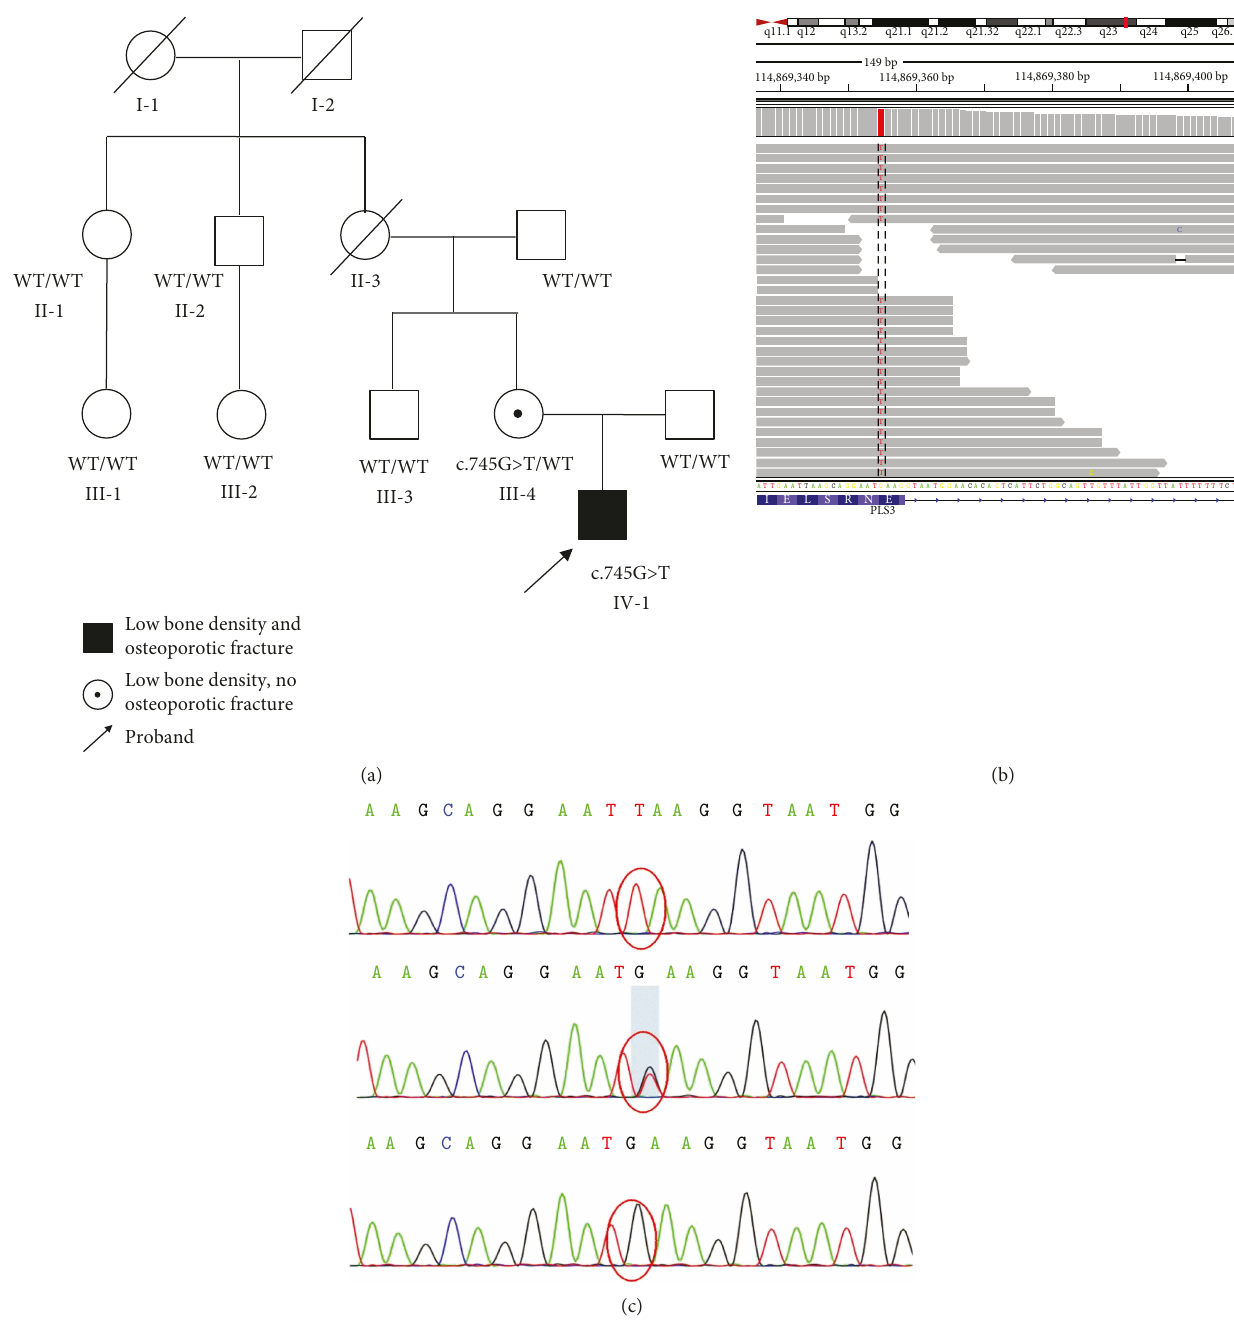
Figure 1: Genetic characterization of the patient described. (a) Family pedigree. Mutation status of PLS3 c.745G > T is indicated beneath symbols for each subject. WT indicates wild-type. (b) Schematic representation of the mapped exome sequencing reads visualized using the Integrative Genomics Viewer (IGV) browser for the proband and his parents. The red lines indicate the mutation. (c) Sanger sequencing of three individuals in the family over the c.745 position in PLS3 . The upper panel shows the c.745G > T variant in the patient, the middle panel shows c.745G > T mutation in the heterozygous mother, and the lower panel shows WT in the patient ’ s